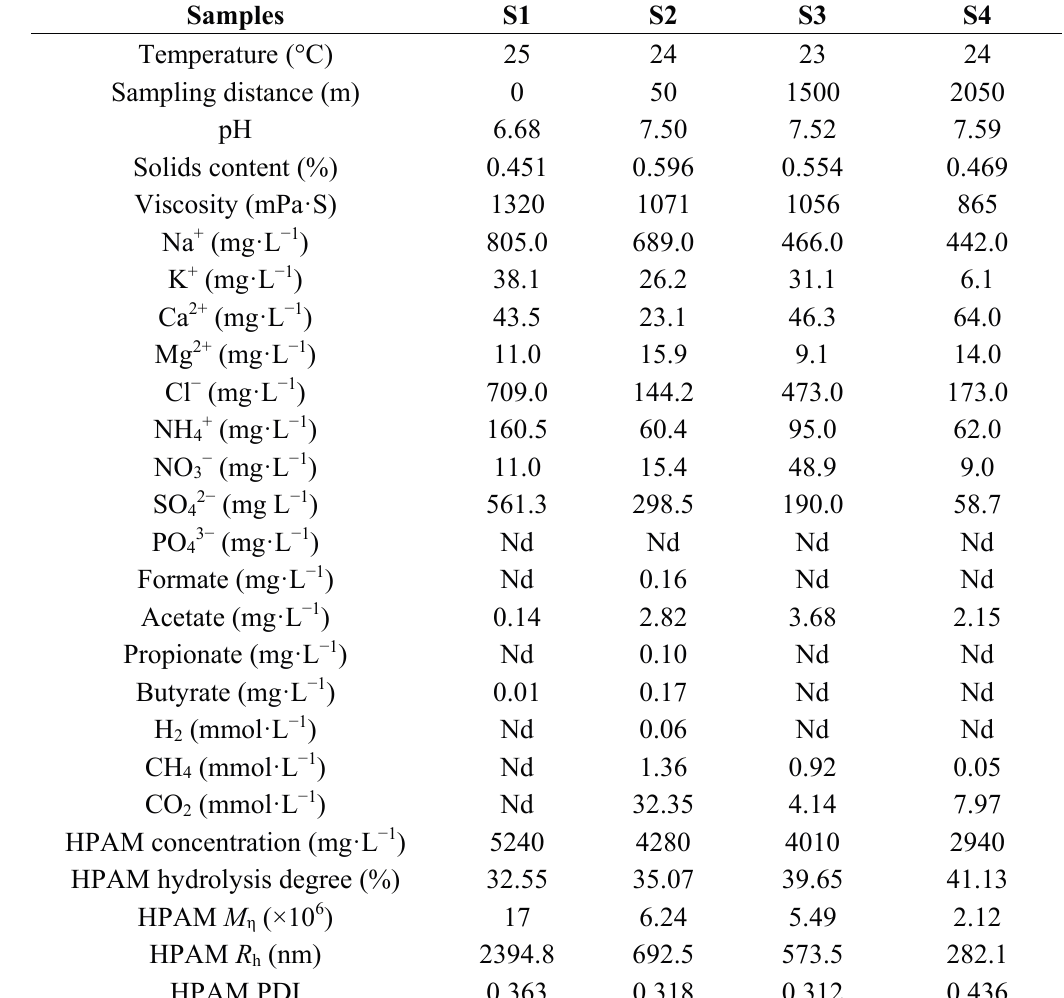
Table 1. Environmental factors and HPAM physicochemical properties of